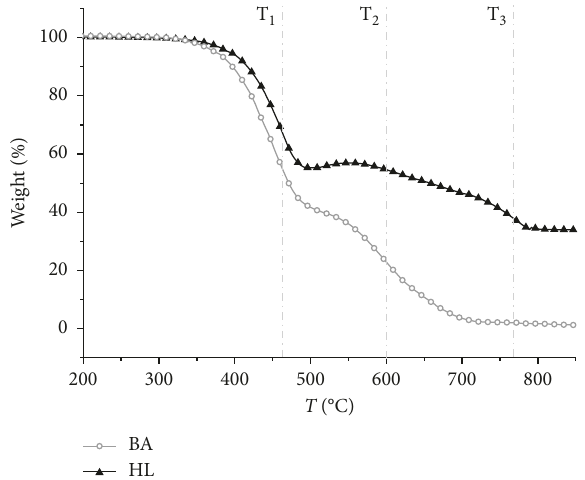
Figure 1: RSR curves of asphalt binder and mastics.